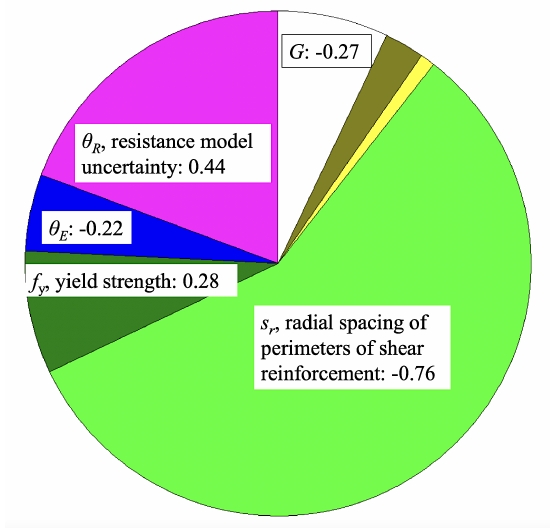
Figure 4. Sensitivity factors for basic variables con- sidering the EN 1992-1-1